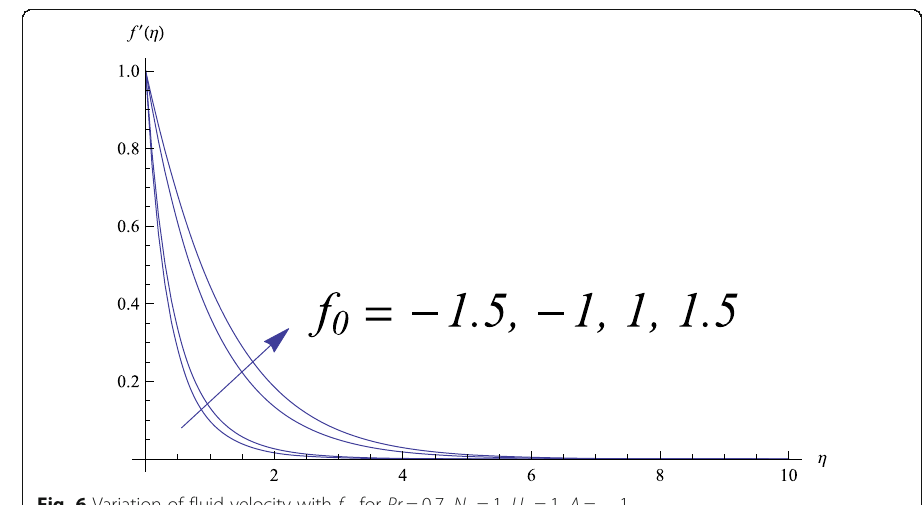
Fig. 6 Variation of fluid velocity with f 0 , for Pr = 0.7, N R = 1, U 0 = 1, A = − 1